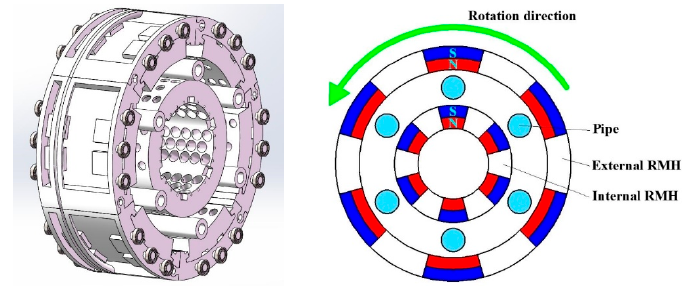
Figure 3. Schematic diagram of RMH structure.